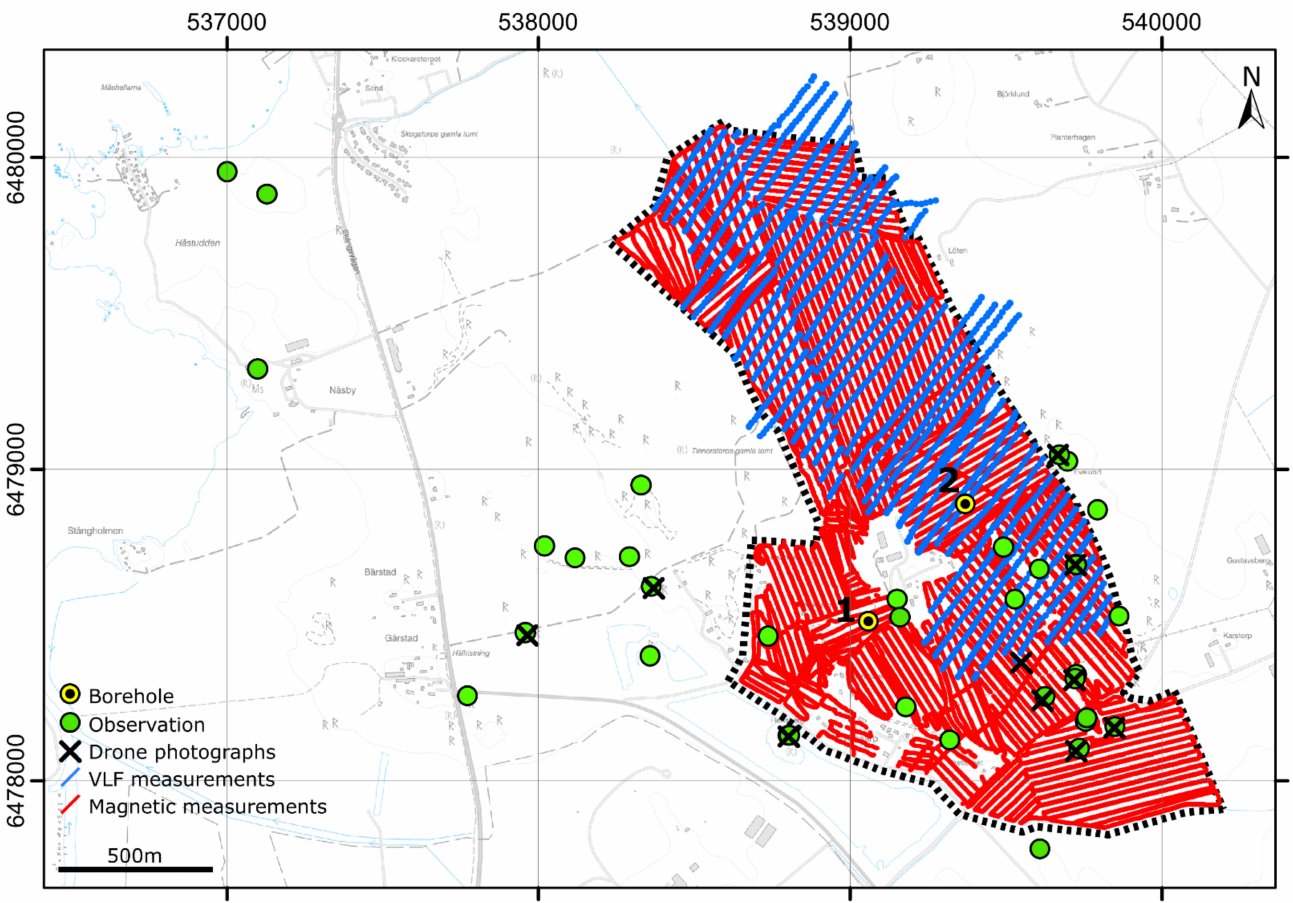
Figure 3. Base map showing the location of data acquired during this study. Borehole 1: Distorp Hagen, 2: Distorp